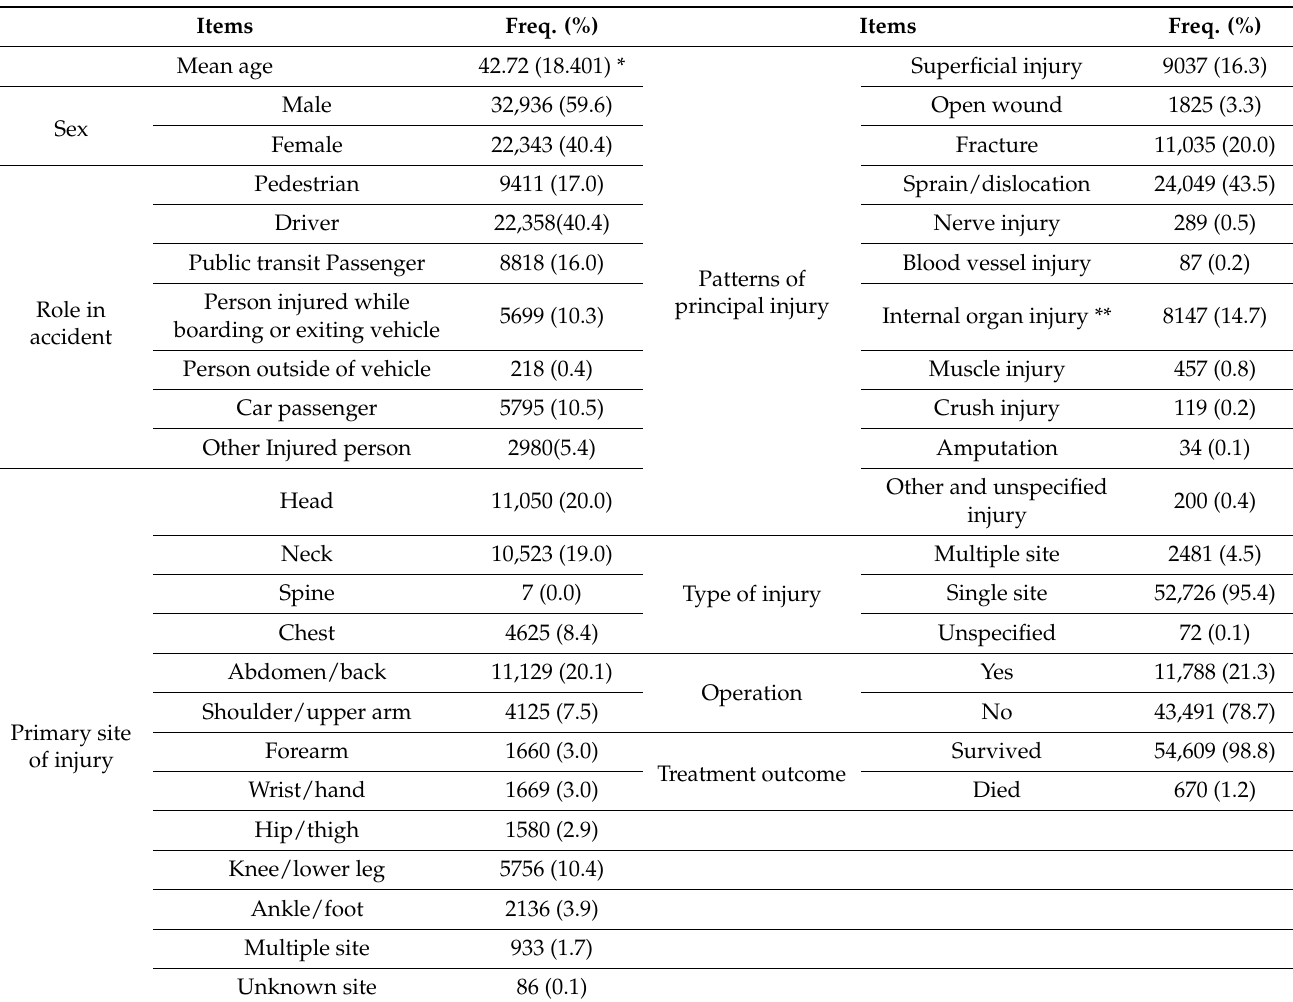
Table 1. Frequency